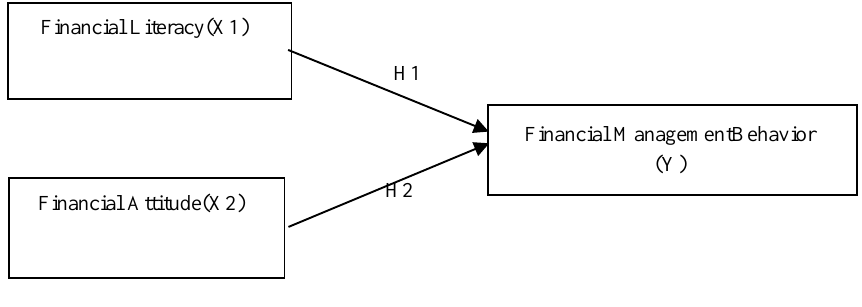
Figure 1: Research